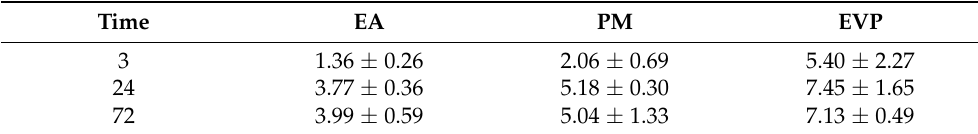
Results are presented as the mean ± S.D. (n =